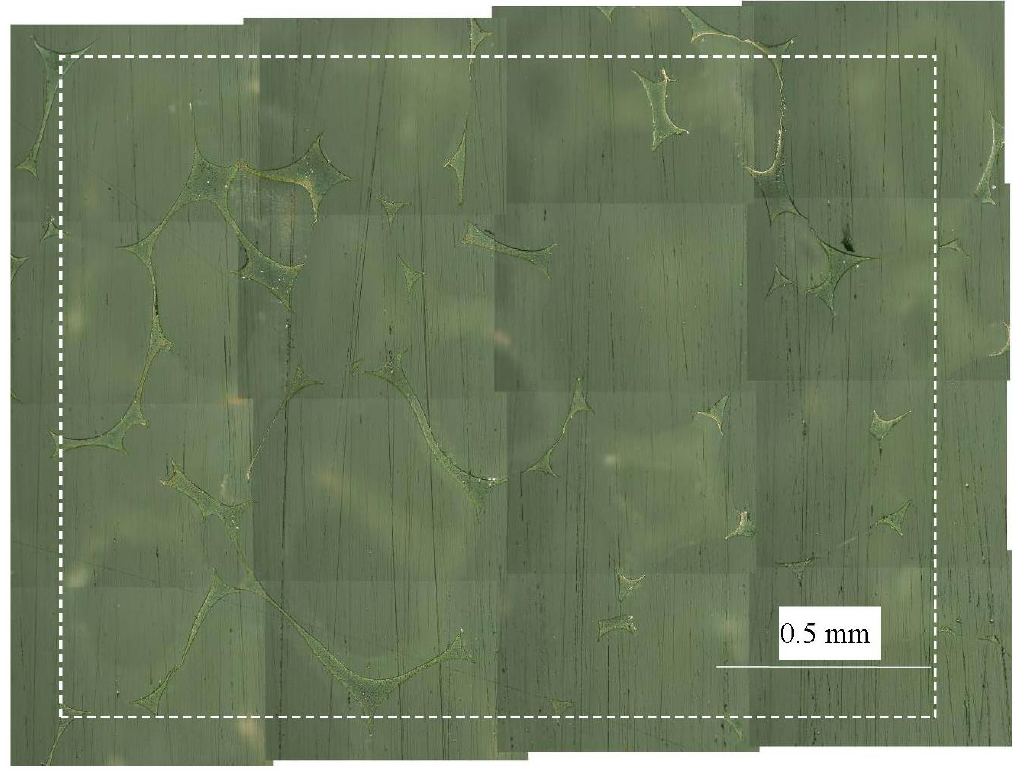
Figure 6. Surface of the conductive foam block. The compression pressure was 0.0 kPa. This figure is the combination of 16 images. Spiky long and thin features are fibers of the conductive foam. The broken-line rectangle shows the observation area (2.0 mm × 1.5 mm).